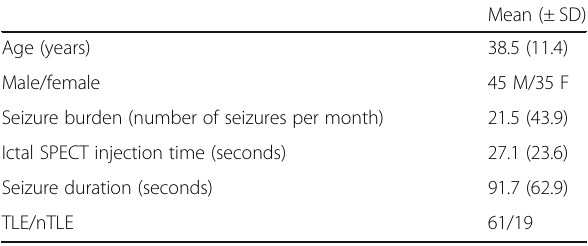
Table 1 Patient demographics and clinical